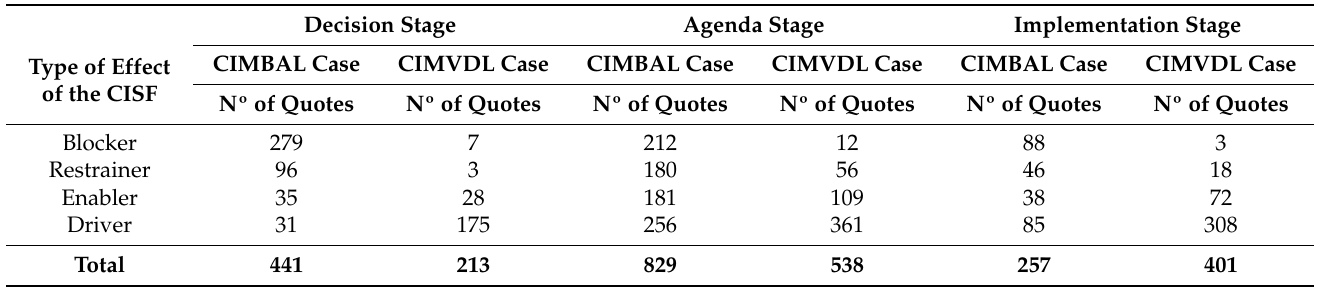
Table 6. Justificative Evidences of the Success/Failure in the Decision, Agenda and Implementation Stages. Source: the